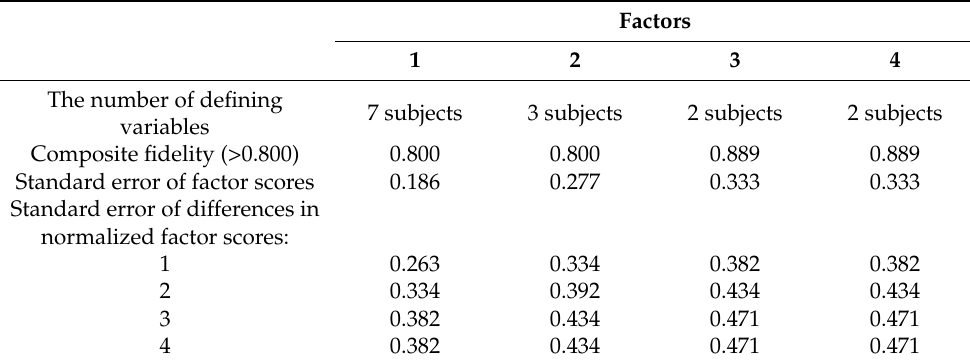
Table 4. Statistical indicators for Q factor